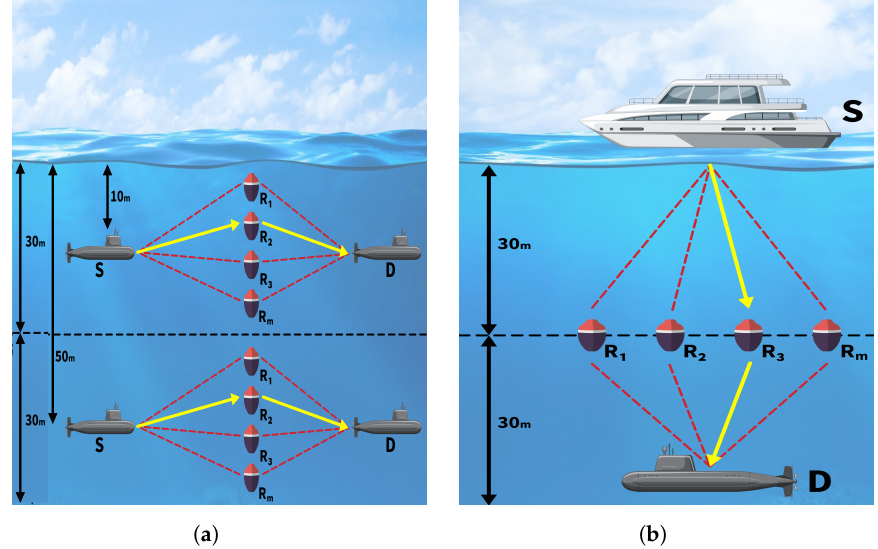
Figure 1. UWVLC cooperative communication systems. ( a ) Horizontal. ( b )